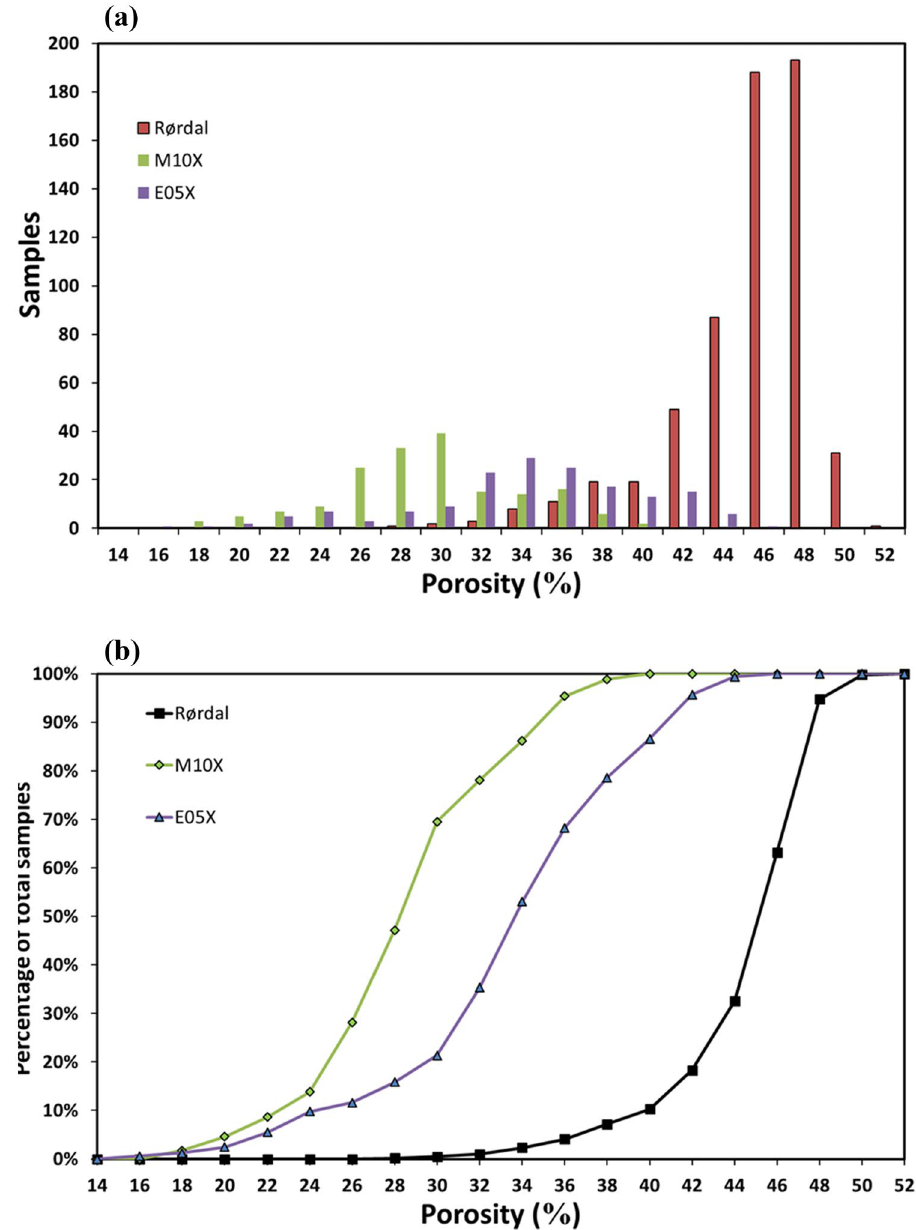
Fig. 6 Distributions of porosity from the Rørdal quarry and the North Sea E-5X and M-10X wells: ( a ) Histogram and ( b ) Cumulative